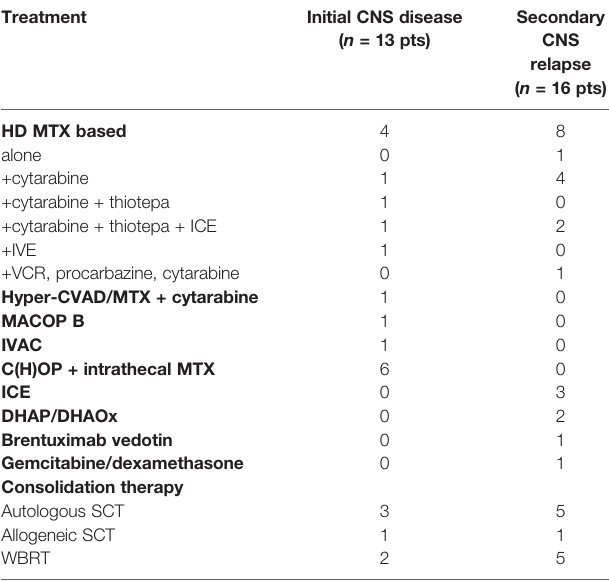
TABLE 4 | Treatment of patients with peripheral T-cell lymphomas and CNS involvement at presentation or relapse ( n = 29).